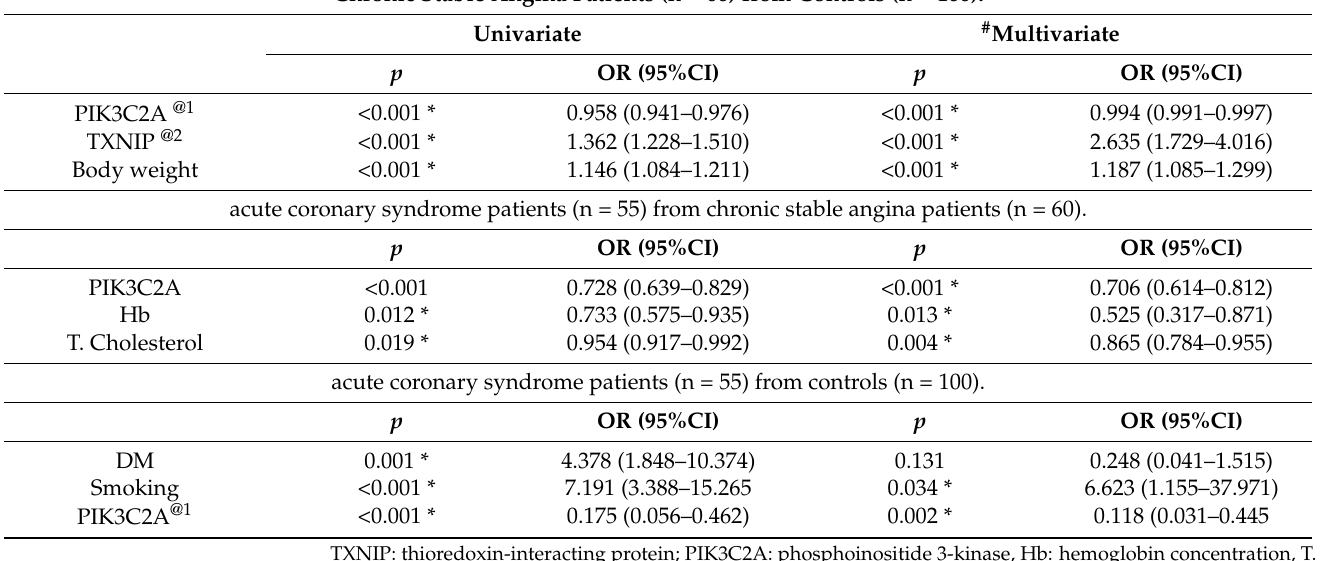
Table 5. Univariate and multivariate logistic regression analysis for the parameters affecting studied